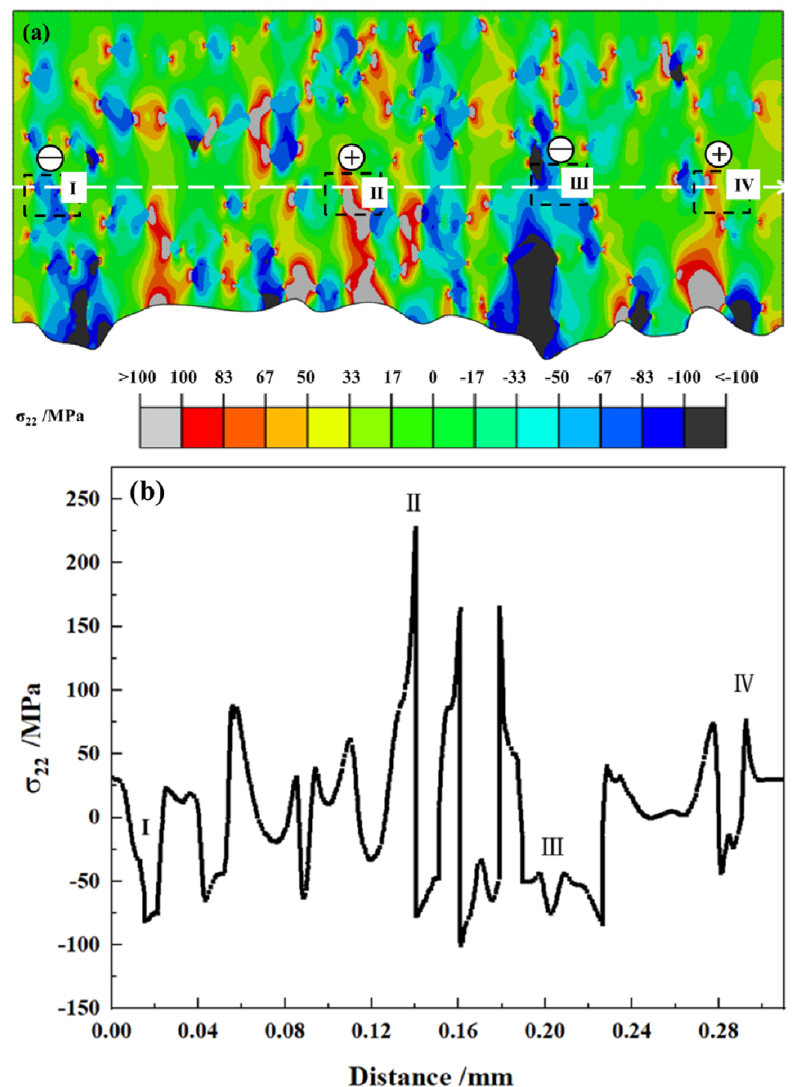
Figure 4. ( a ) Misses stress; ( b ) σ 22 and ( c ) σ 12 stress distribution of top coats in NC1, NC2, NC3 and NC4.